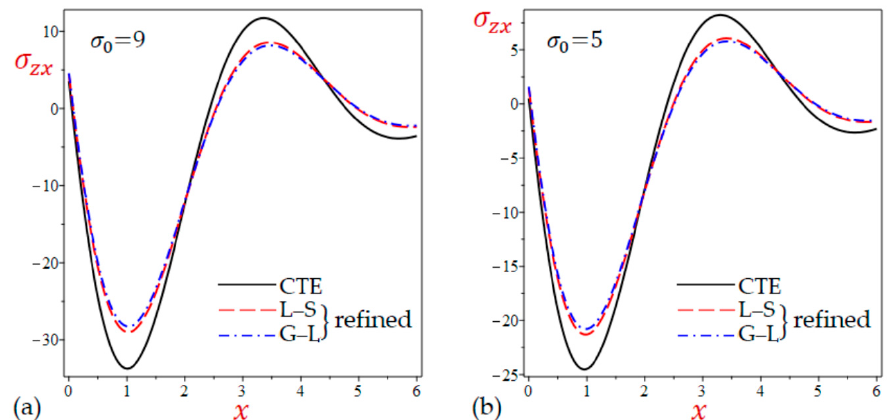
Figure 7. Effect of initial stress σ 0 on the transverse shear stress σ zx of the rotating half-space with initial pressure ( 𝓅 = 10 ) ( a ) σ 0 = 9; ( b ) σ 0 = 5.